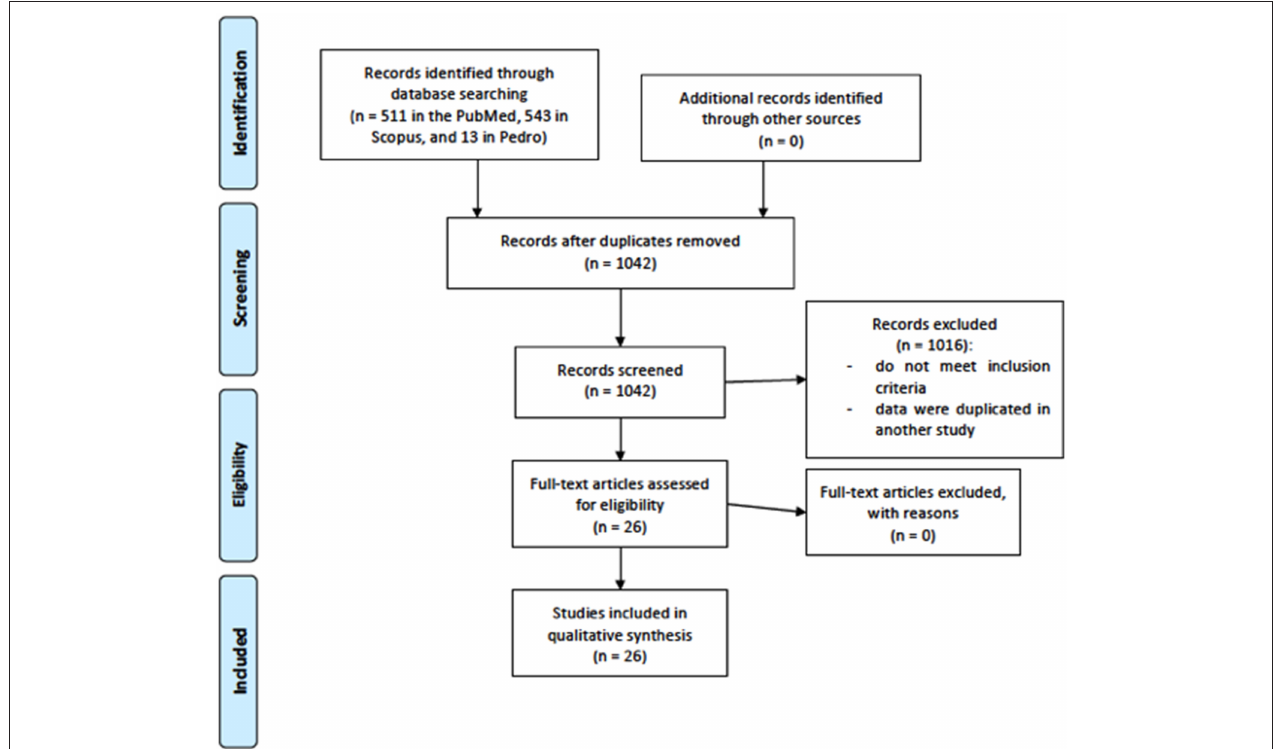
FIGURE 1 | Flow chart for study